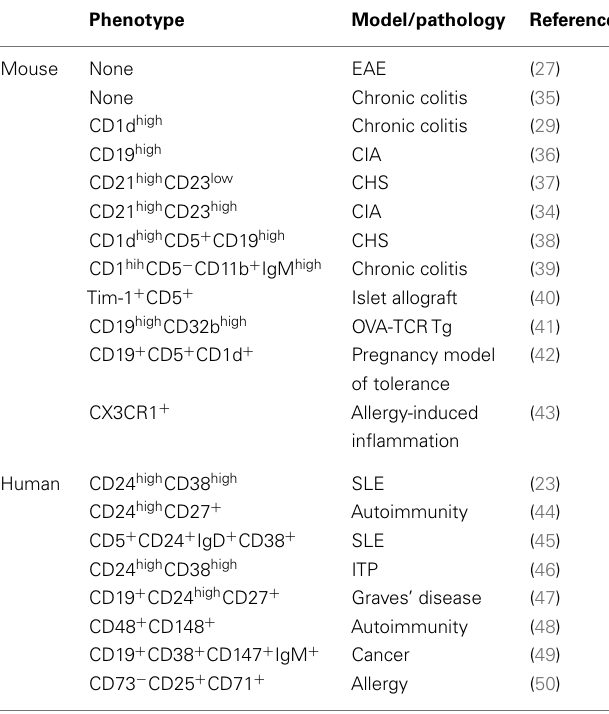
Table 1 | Immunophenotype of the regulatory B cells identified in mouse models and human